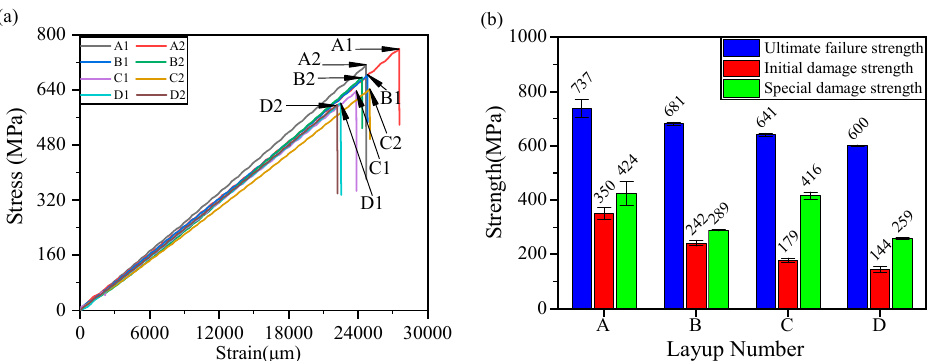
Figure 9. Ultimate failure strength, initial damage strength, and special damage strength (( a ) stress vs. strain, ( b ) three kinds of strengths vs. layup